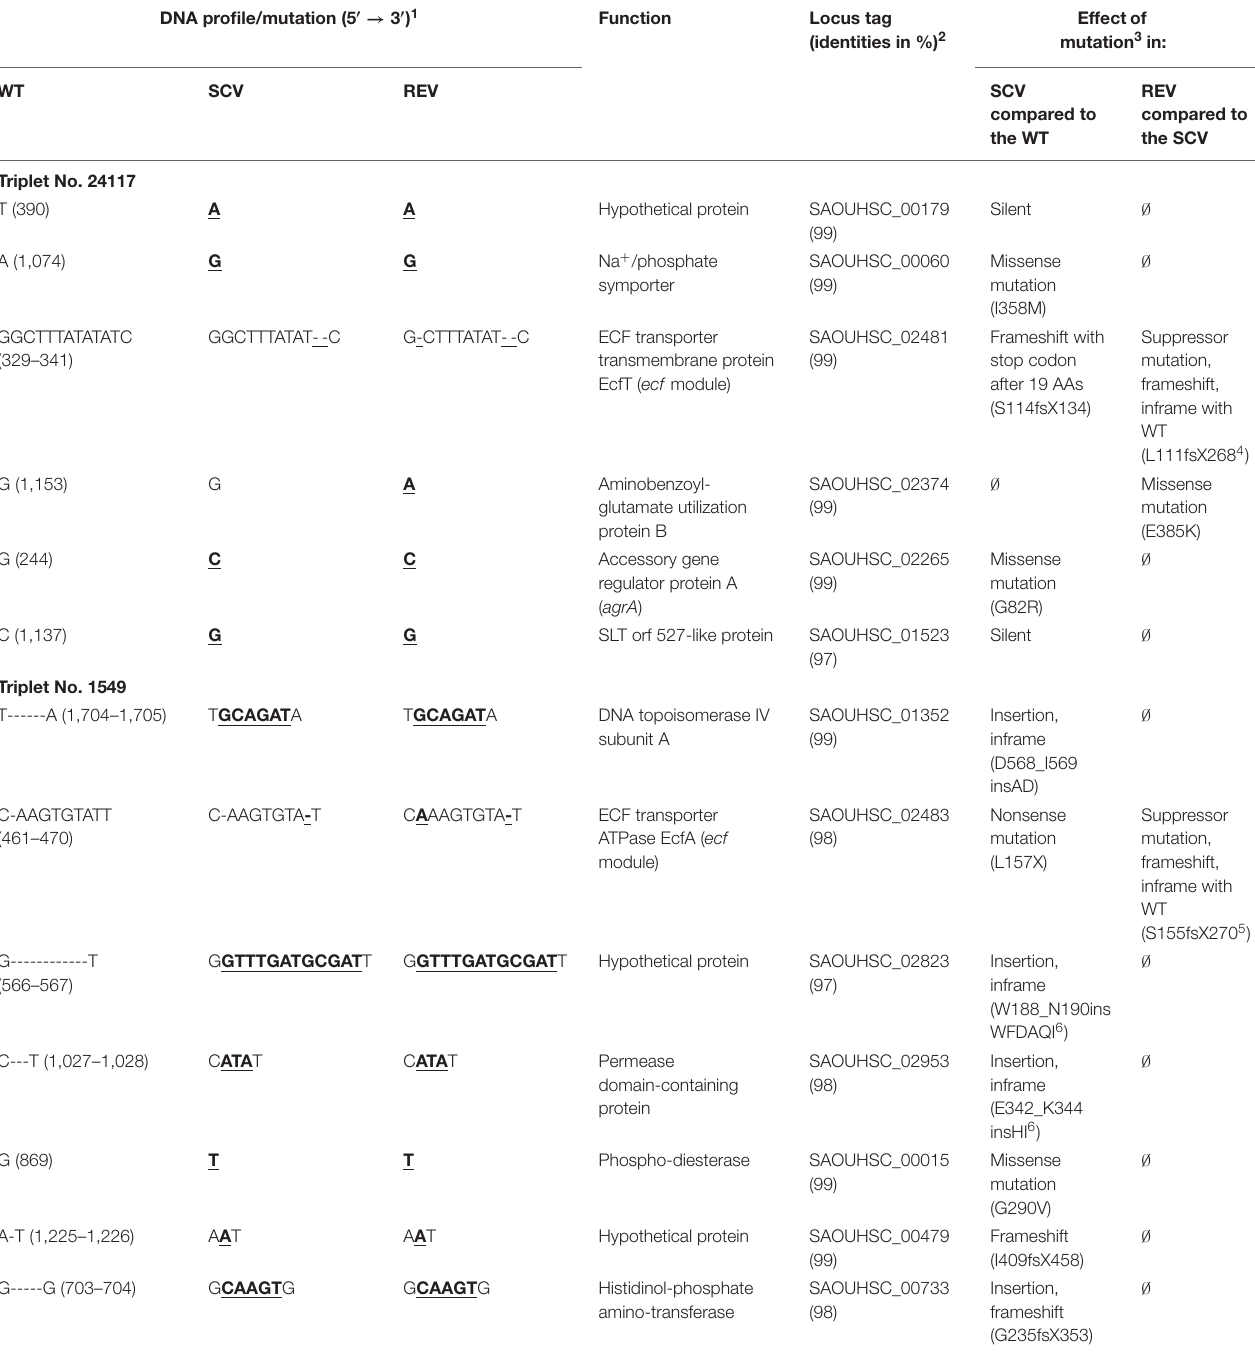
TABLE 4 | Genetic alterations between the three phenotypes of two S. aureus strain triplets detected with a whole-genome sequencing approach. DNA profile/mutation (5 (cid:48) → 3 (cid:48) ) 1 Function Locus tag